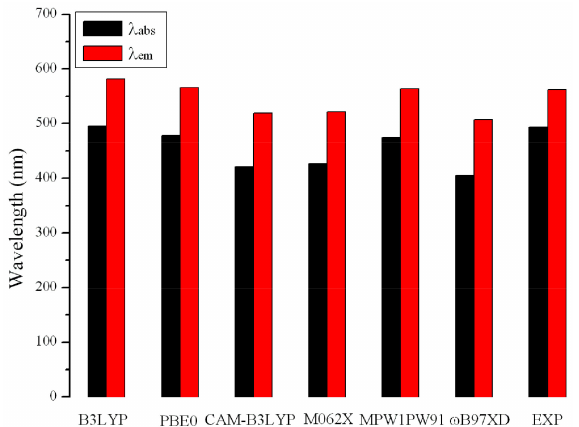
Figure 6. Calculated absorption and fluorescence wavelengths ( λ abs and λ flu ) of molecule 1 using various functionals, together with the experimental